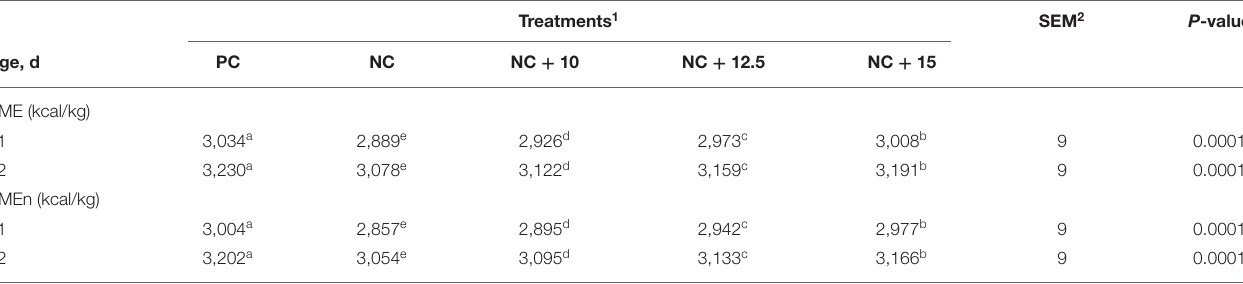
TABLE 3 | Apparent metabolizable energy corrected for nitrogen (AMEn) of broilers raised to 42 d. Treatments 1 SEM 2 P -value